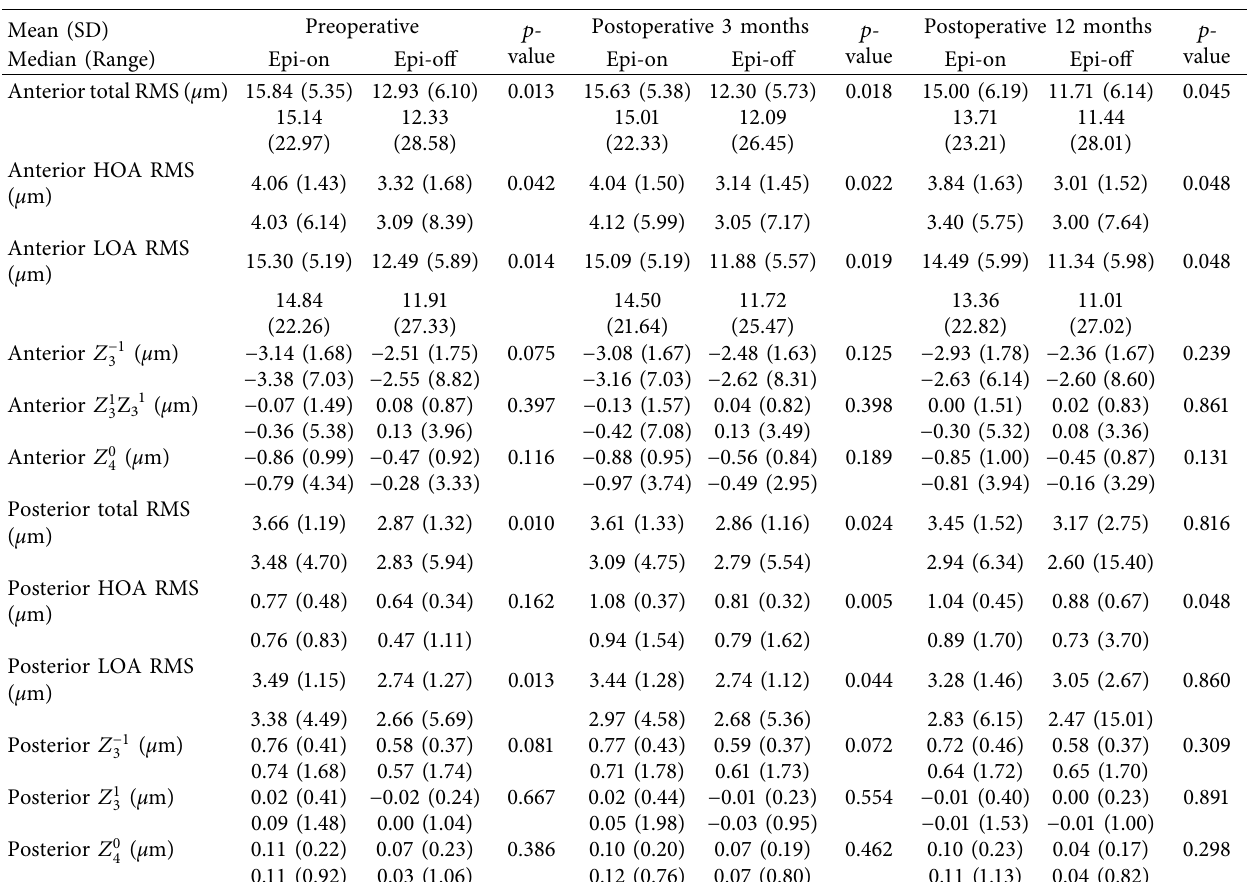
Table 5: Differences between epi-on and epi-off groups in corneal topometric parameters in the different visits of the follow-up. Mean